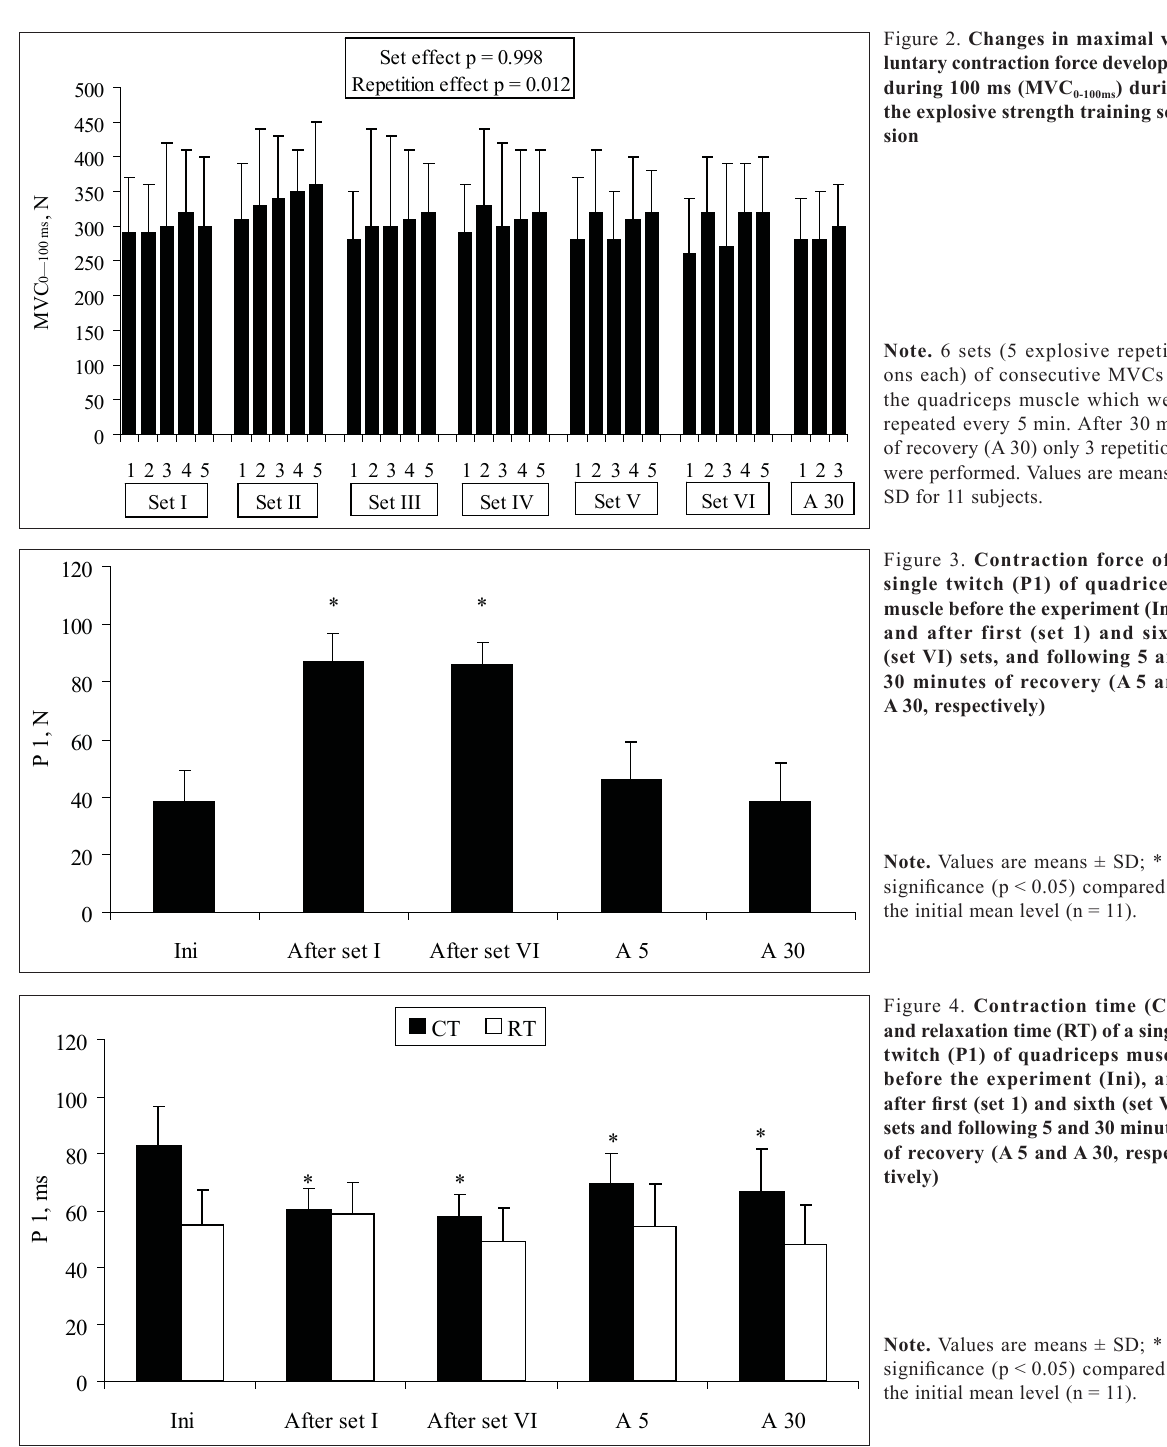
Figure 2. Changes in maximal vo- luntary contraction force developed during 100 ms (MVC the explosive strength training ses-